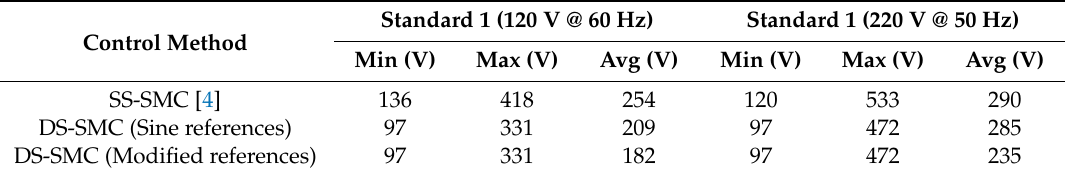
Table 7. Comparison of control methods regarding semiconductor voltage stress.